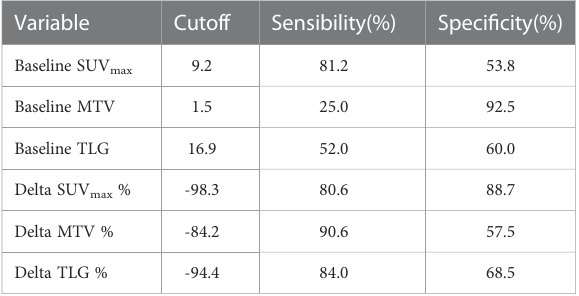
TABLE 2 Optimal Metabolic Parameters Cutoff Values for